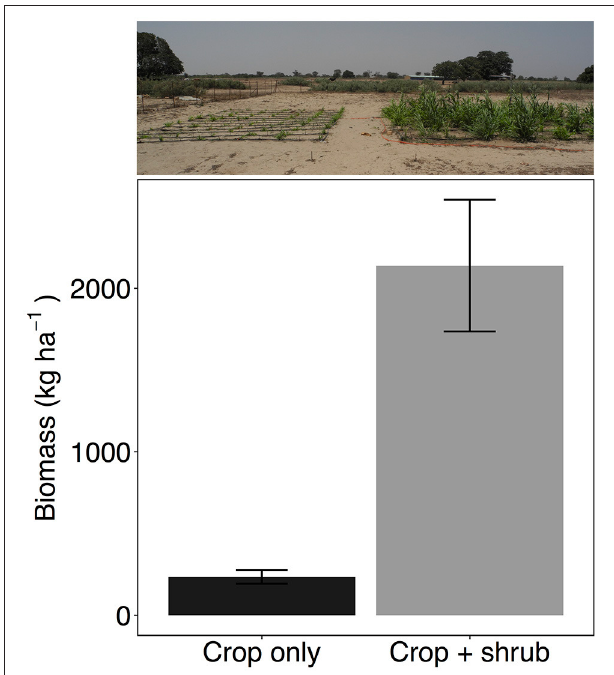
FIGURE 3 | Biomass yield of millet ( Pennisetum glaucum) crop grown alone or in association with Guiera senegalensis ( n = 3 per treatment). Error bars are one standard error, treatments are significantly different ( P < 0.05). Photo is taken in plot